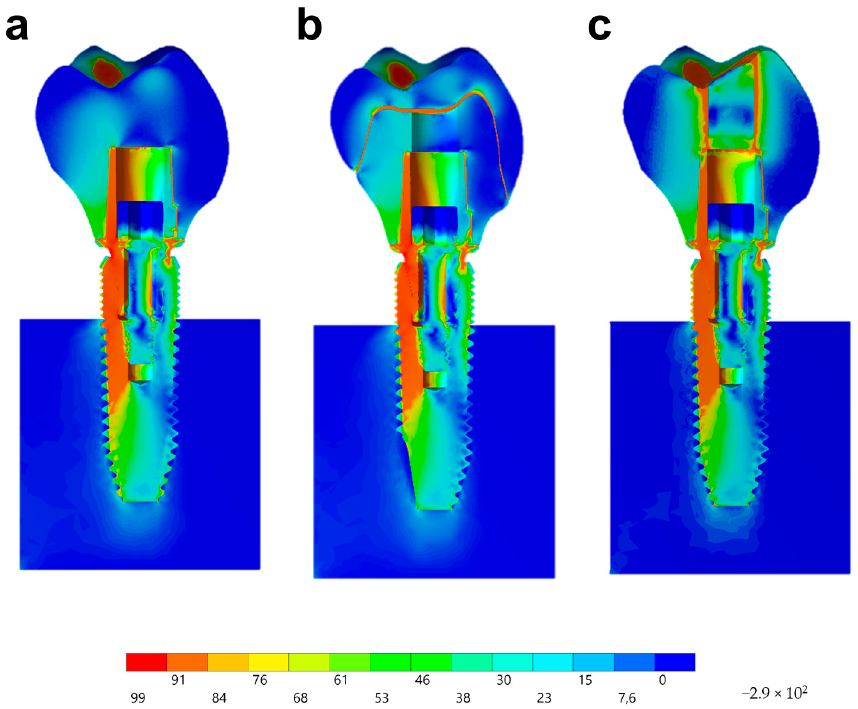
Figure 14. Stress distribution assessed by the von-Mises criterion according to the design of the restoration. ( a ) MC, ( b ) CME, and ( c ) MP.